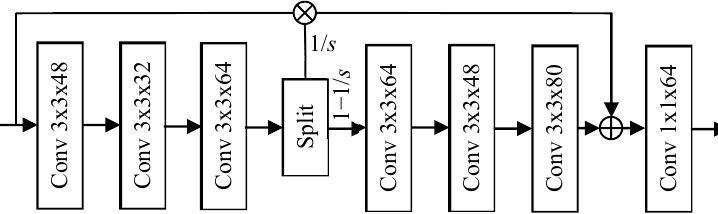
Figure 2. Architecture of information distillation block (IDB) in MSM-CNN, where s stands for the number of parts into which the feature maps are split, and ⊗ is the concatenation operator.